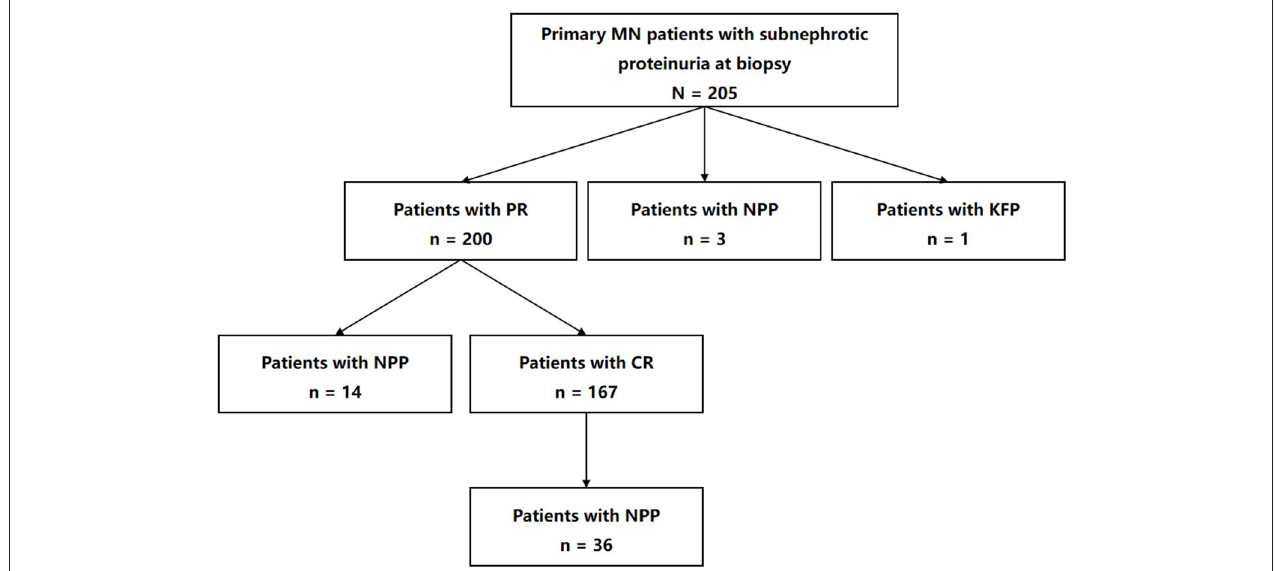
FIGURE 2 | Flow diagram of numbers and sequences of the participants that reached various outcomes in the study. MN, membranous nephropathy; PR, partial remission; NPP, nephrotic proteinuria progression; KFP, kidney function progression; CR, complete remission.